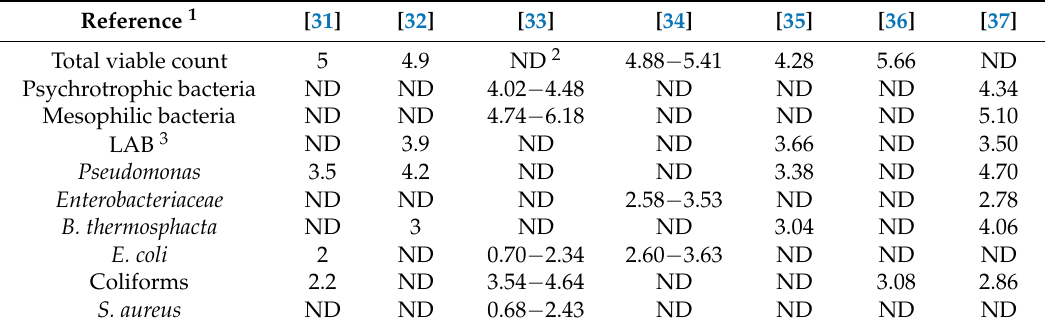
Table 1. Values reported for various bacterial groups or species contaminating poultry meat at the beginning of the storage period. Values are expressed in log colony forming units (CFU)/g and have been collected from different